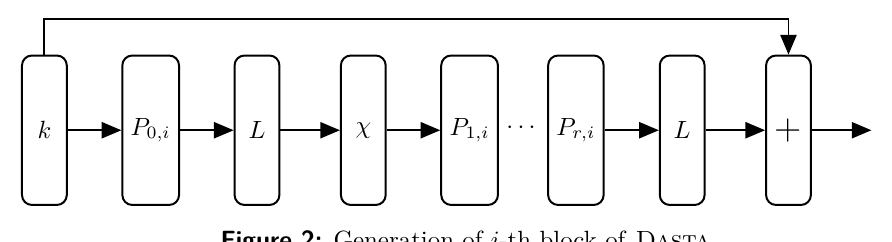
Figure 2: Generation of i -th block of Dasta